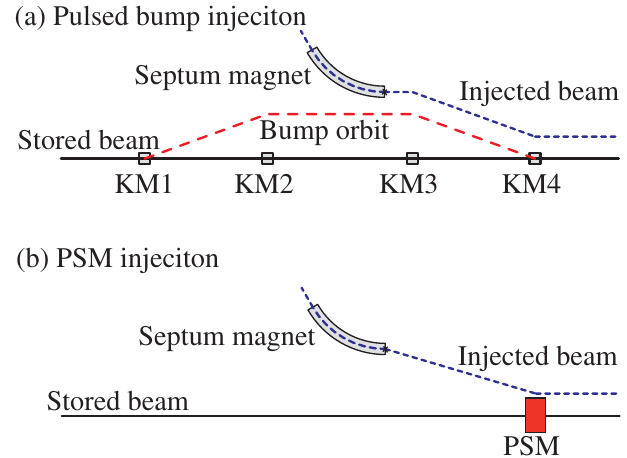
FIG. 1. (Color) A schematic view of beam injection. (a) Conventional pulsed bump injection. The bump orbit (red) is employed by four pulsed dipole kicker magnets (KM1-KM4). Trajectories of the injected beam (blue) and the stored beam (black) are shown. (b) PSM